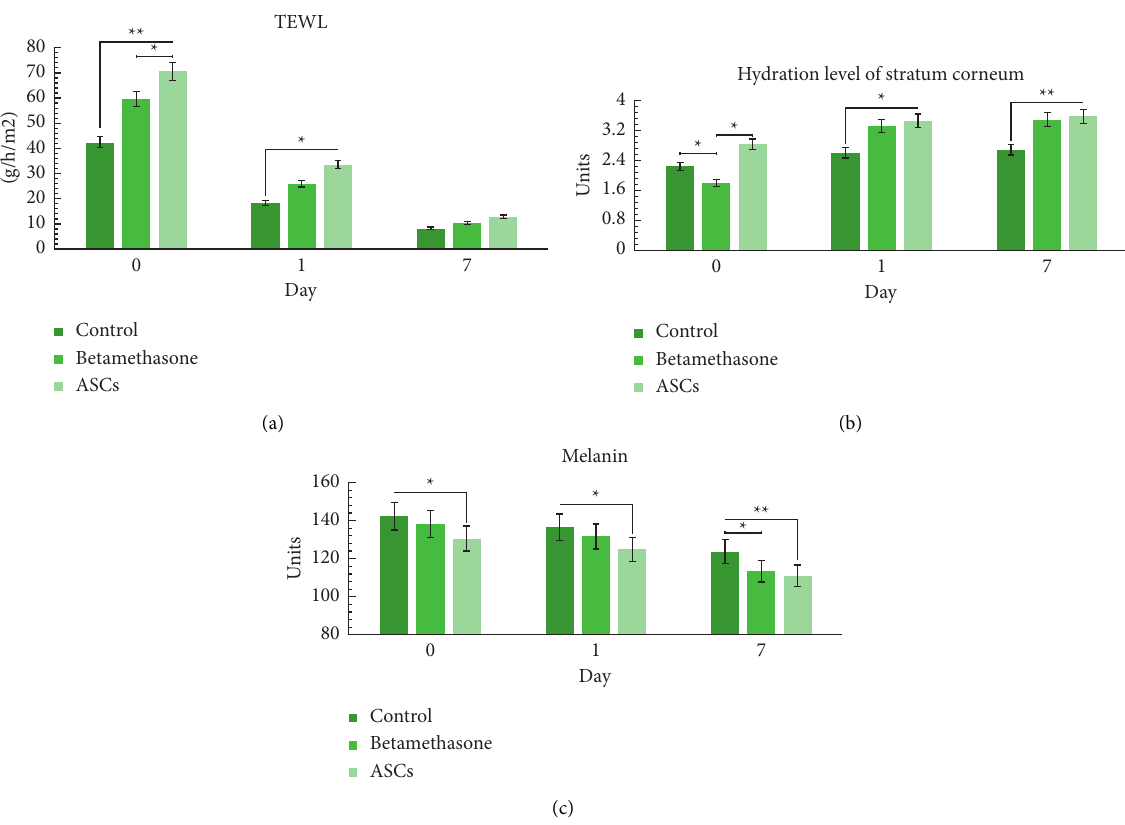
Figure 2: (a) TEWL level as an indicator of water loss, (b) hydration level in stratum corneum, (c) melanin content of UVB-irradiated skin in treated (betamethasone and ASC groups) and control groups on day 0, 1, and 7. Error bar: mean ± SD ( ∗ p ≤ 0.05, ∗∗ p ≤ 0.01).